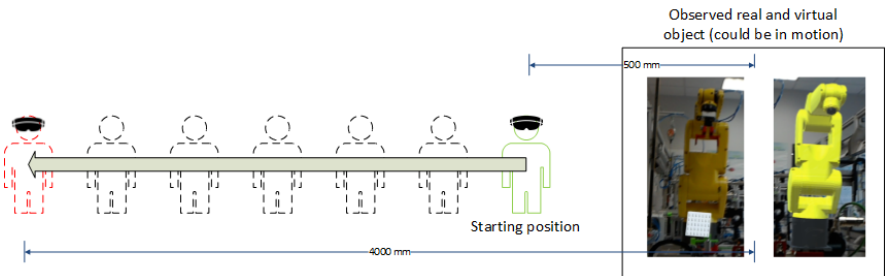
Figure 10. Schematic diagram of an experiment to evaluate the accuracy of distance measurement depending on the operator’s location.